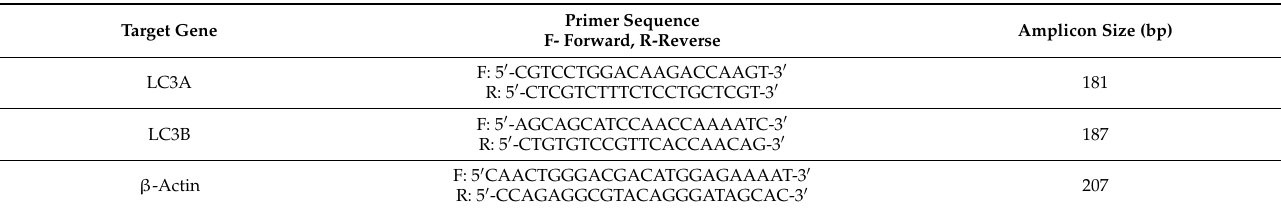
Table 1. RT-PCR Primer